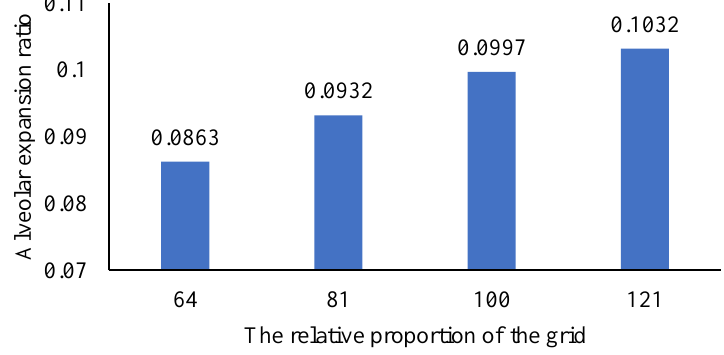
Figure 4. The influence of changing the proportion of the grid on the proportion of alveolar expan- sion.